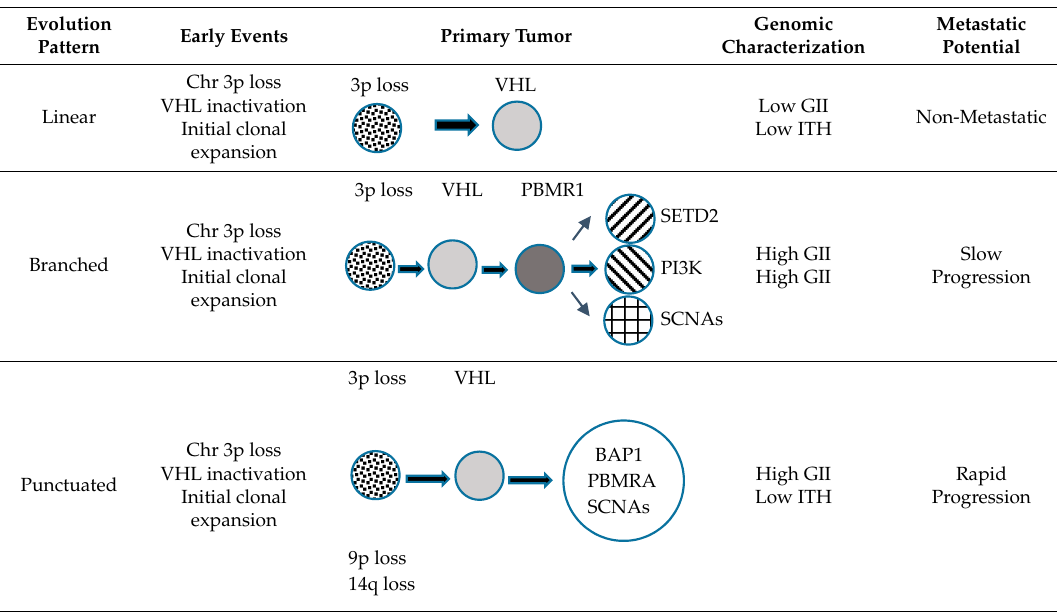
Table 3. Evolutionary patterns of clear-cell RCC (CCRCCs) that are associated with the development of different metastatic potentials. Tumors that follow a linear pattern of evolution have a limited intratumor heterogeneity (ITH), a low genomic instability index (GII), few mutations in addition to VHL and a low fraction of their genome affected by copy number alterations (SCNAs), and display a low metastatic potential. The branched pattern of tumor progression implies high ITH and GII, the progressive acquisition of additional mutations after VHL loss, with early acquisition of PBMR1 mutations and then subclonal acquisition of additional genetic alterations ( SETD2 mutations, PI3K-AKT-mTOR pathway mutations,), associated with a slow metastatic development. The punctuated pattern is characterized by high GII and low ITH, early chromosome 9p and 14q loss, acquisition of multiple driver mutations, including BAP1 mutations and rapid acquisition of a metastatic potential.